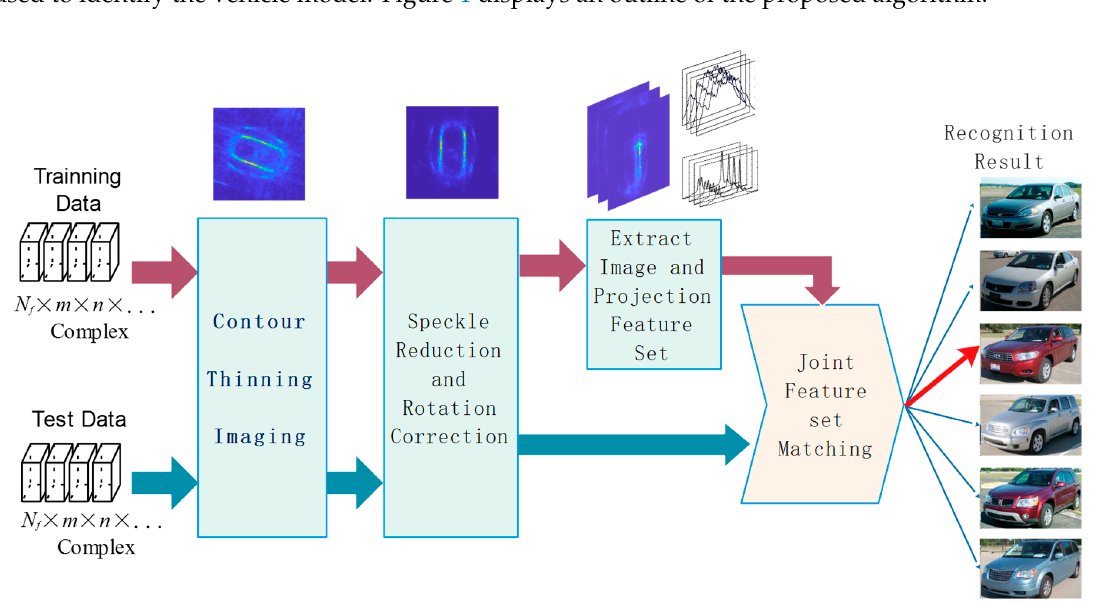
Figure 1. The outline of the proposed joint feature set matching (JFSM) algorithm.